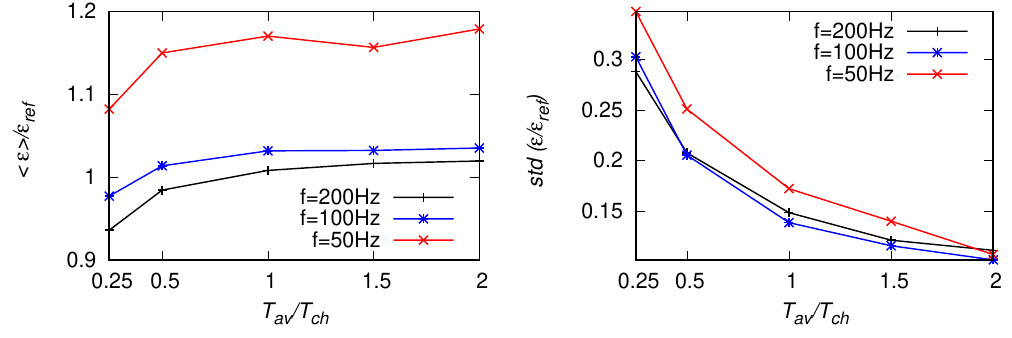
Figure 16. Statistics of (cid:101) VAR estimates based on the variance of velocity derivative, Equation (10), for the fitting range f = [ 10 ÷ 20 ] Hz, from artificial signals with f s = 200 Hz, 100 Hz and 50 Hz. Left panel : EDR averaged along the signal, right panel : standard deviation of the estimates.